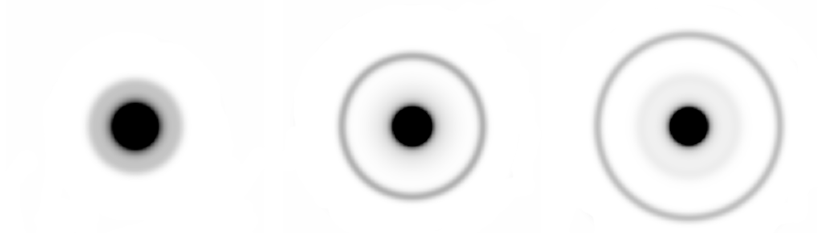
Figure 12 . Snapshots of time evolution of a ‘negative’ ring-like axisymmetric perturbation of the MP black hole (with rotation parameter a = 3). The initial perturbation has amplitude opposite to the one in (cid:12)gure 11, i.e., a bulge at the center, instead of a